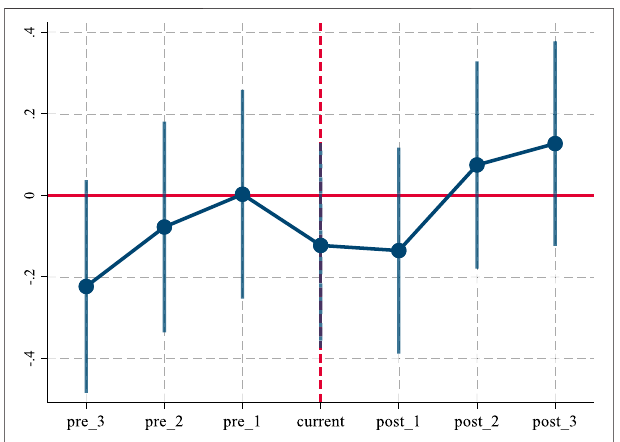
FIGURE 1 | The results of the common trend